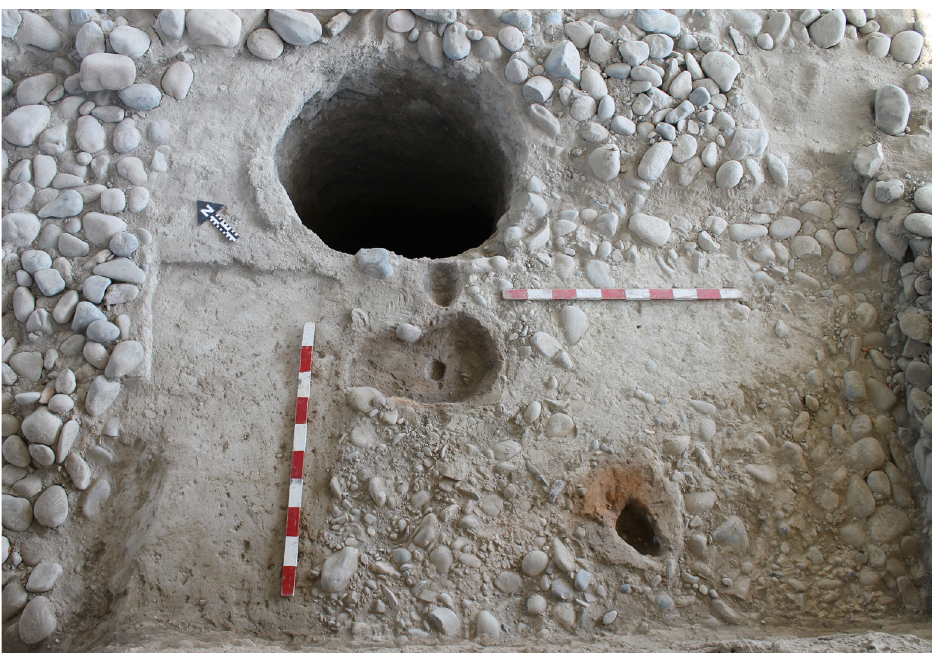
Fig. 8: The workshop (Room C) of Building 1, with three small